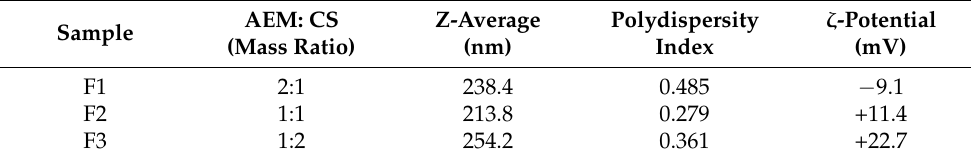
Table 3. Characterization of MTX loaded AEM-CS